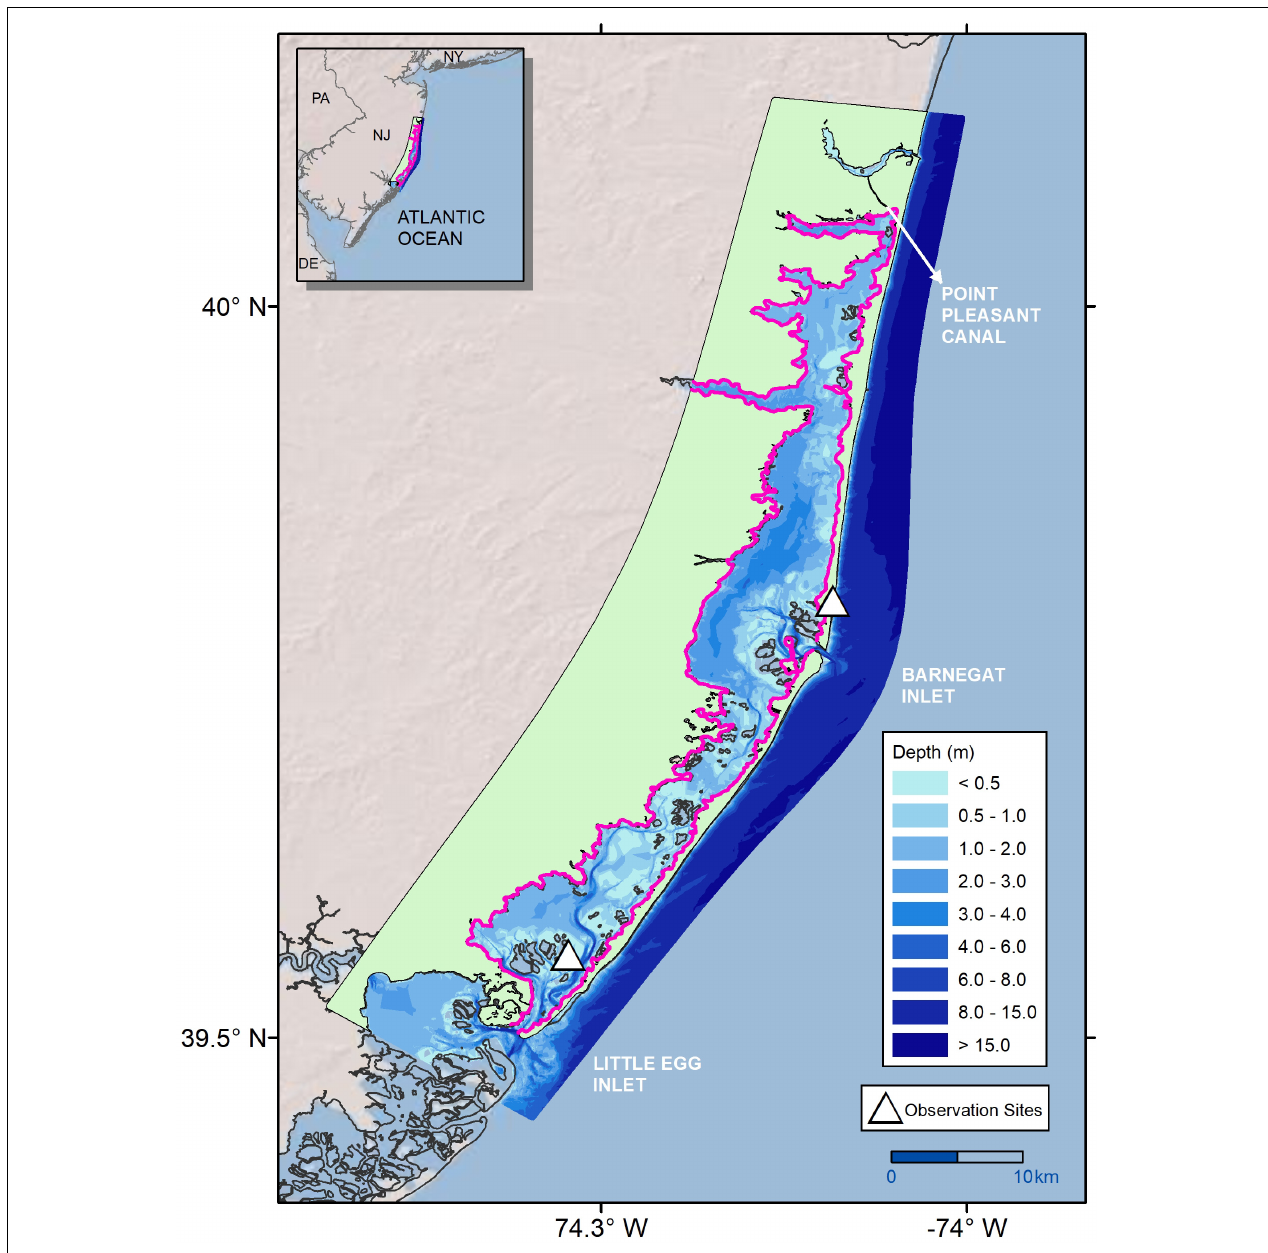
FIGURE 1 | Bathymetry of Barnegat Bay-Little Egg Harbor (BB-LEH) estuary and observation sites used to develop the biomass production model in Straub et al. (2015), with Black outline showing the original computational domain of hydrodynamic model, and Pink outline marking the domain of the coupled production-hydrodynamic